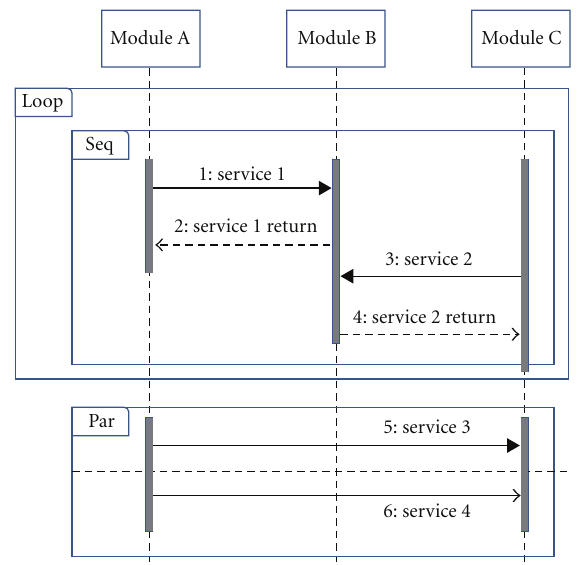
Figure 3: Tracking sequence diagram with parallel communication.